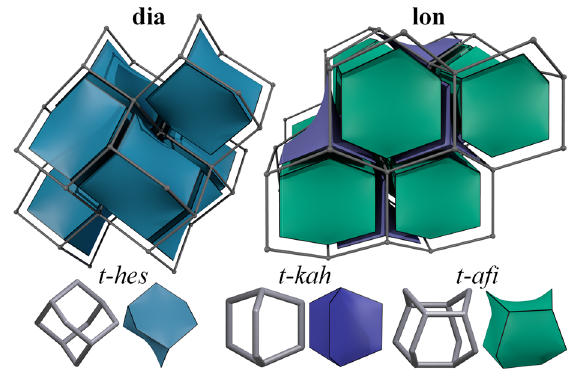
Fig. 3 Diamond and lonsdaleite tilings. Natural tilings and tiles ( t-kah [6 3 ], t-hes [6 4 ], and t-a fi [6 5 ]) in the diamond ( dia ) and lonsdaleite ( lon )